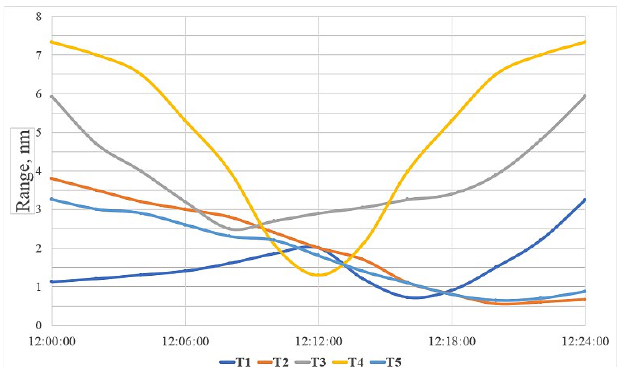
Fig. 10. Dynamic of changing range to five target ships throughout the